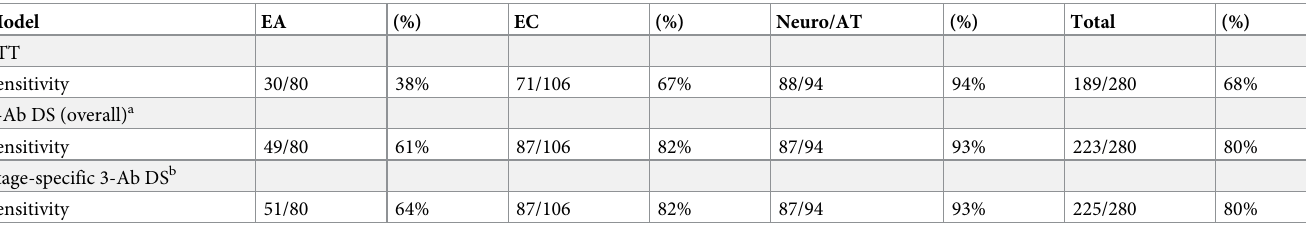
Table 8. Performance of STT, 3-Ab DS trained on entire dataset, and disease stage-specific 3-Ab DS.